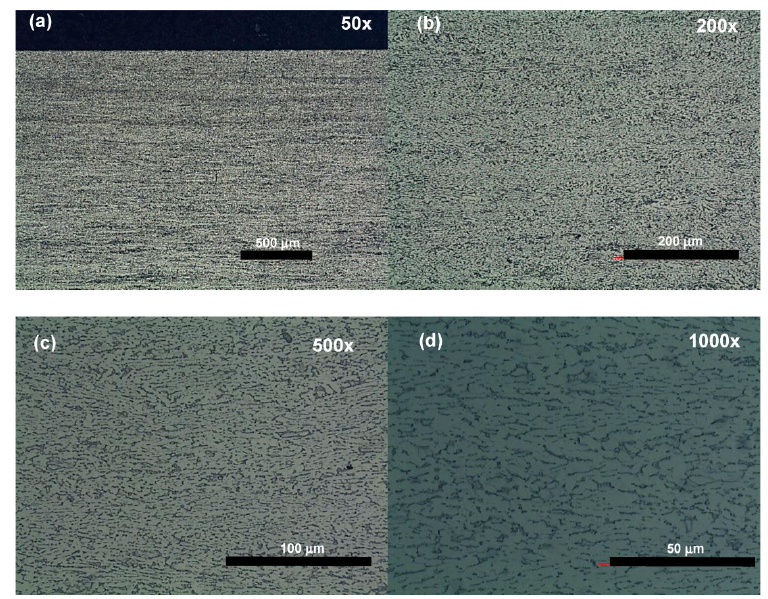
Figure 4. Metallographic images of Ti 6 Al 4 V-BM samples at the indicated magnifications: ( a ) 50×, ( b ) 200×, ( c ) 500×, ( d ) 1000×.